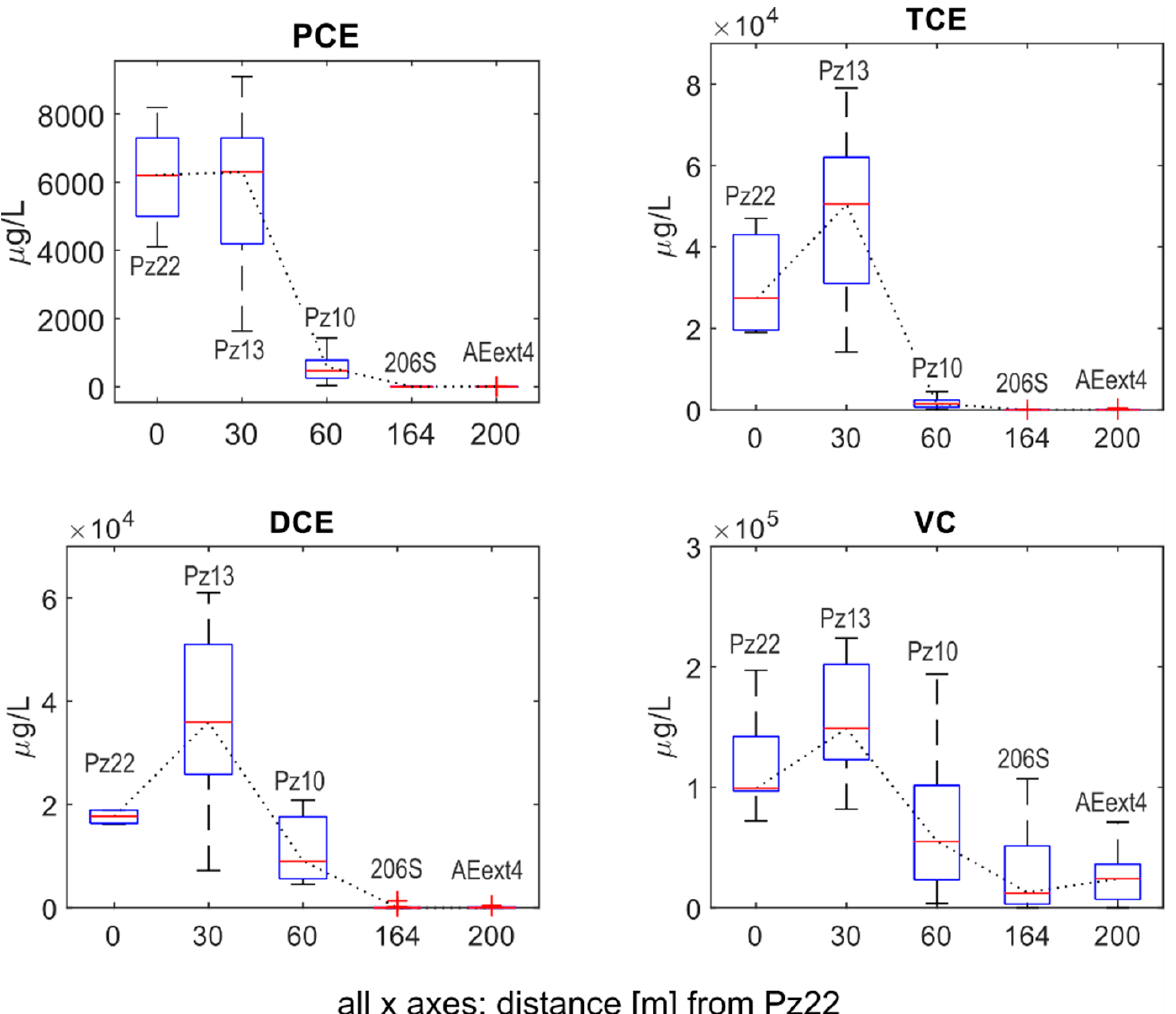
Figure 2. Evolution of the PCE, TCE, DCE and VC concentrations along the transect from Pz22 to AEext4 for all available sampling campaigns. The dotted black line connects the median values (red marks) of the different boxplots.